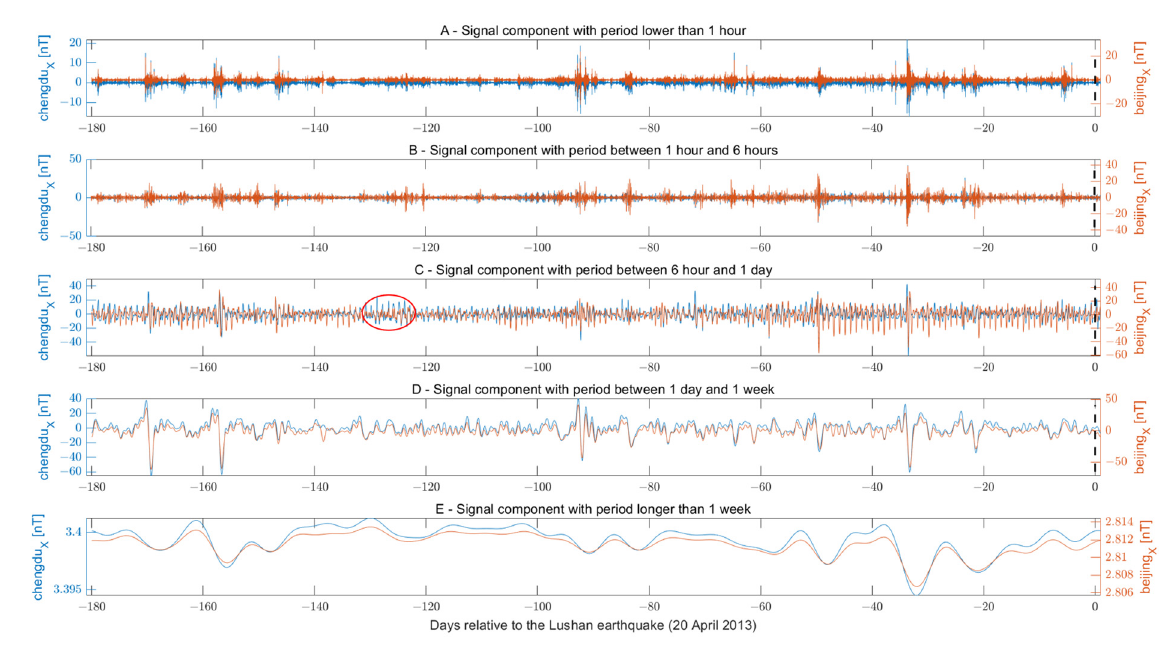
Figure 9. X (North) component of geomagnetic data from CDP (Chengdu, blue lines) and BMT (Beijing, orange lines) ground observatories. The data were filtered into five frequency bands. The red oval highlights more signals from the Chengdu observatory with respect to the Beijing observatory.